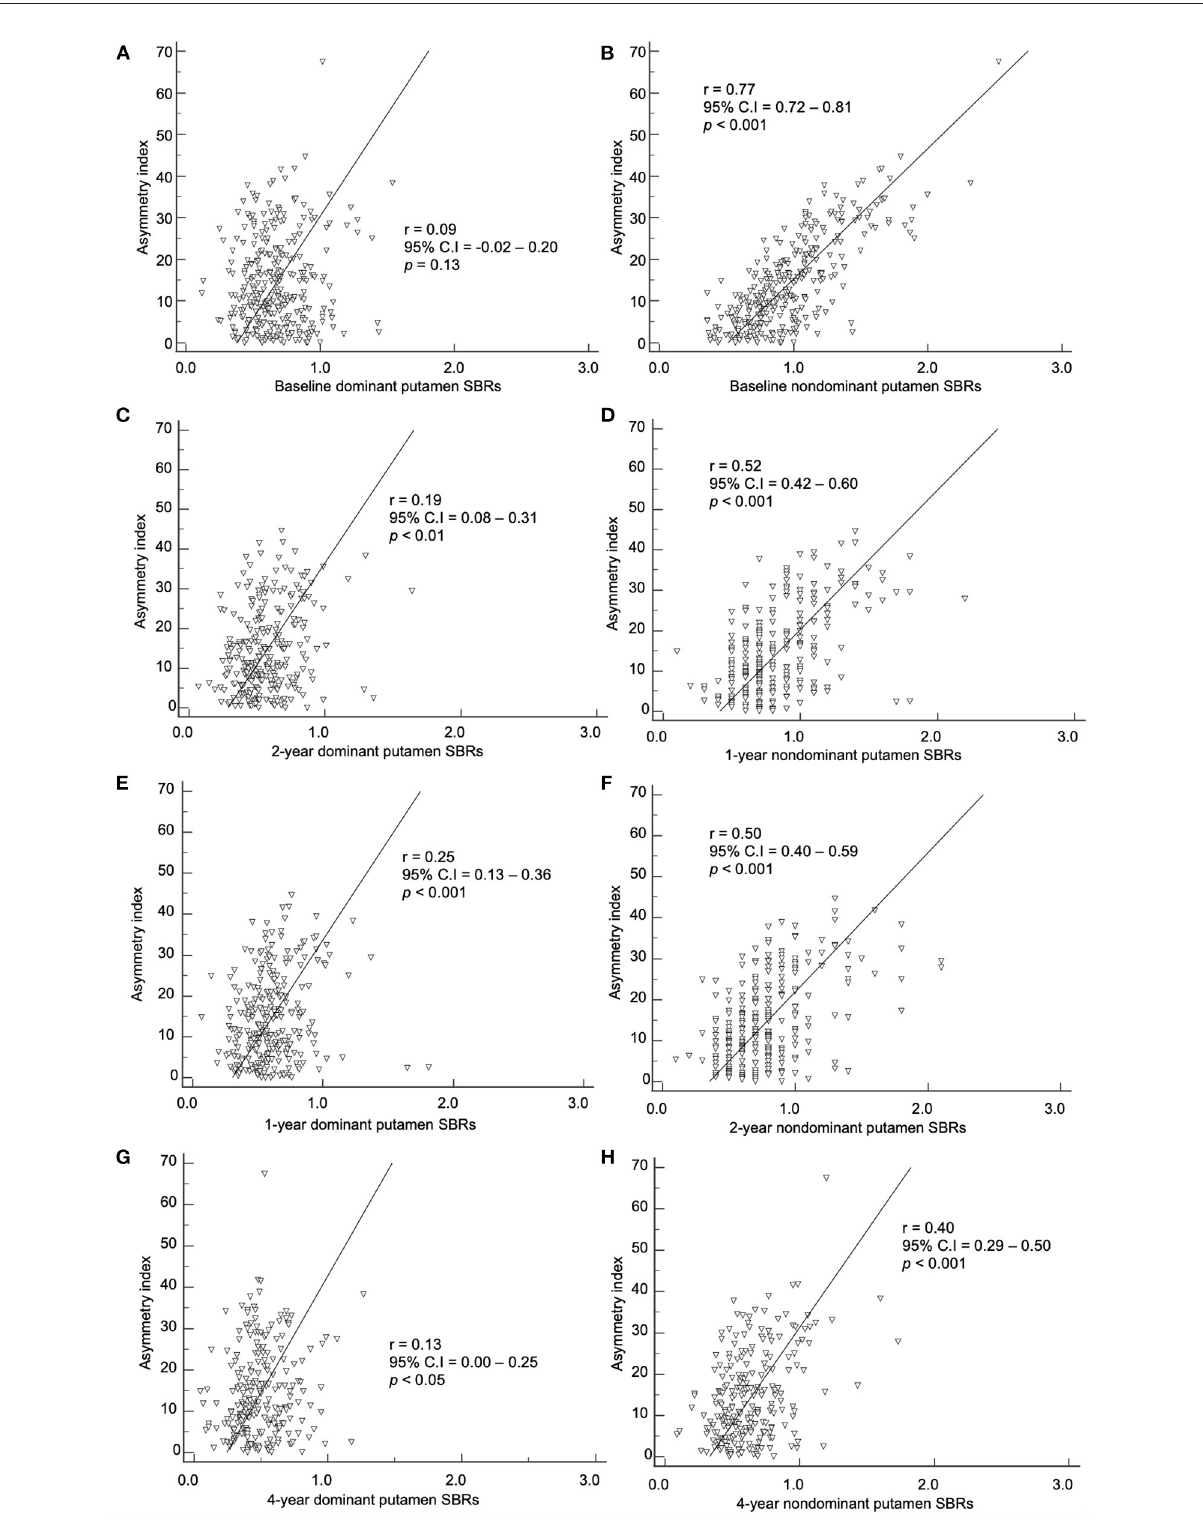
FIGURE5 Correlation of the baseline asymmetry index of the putamen by method 2 with SBRs of (A) baseline, (C) 1-year, (E) 2-year, and (G) 4-year. Correlation of the baseline asymmetry index of the putamen by method 2 with SBRs of (B) baseline, (D) 1-year, (F) 2-year, and (H)